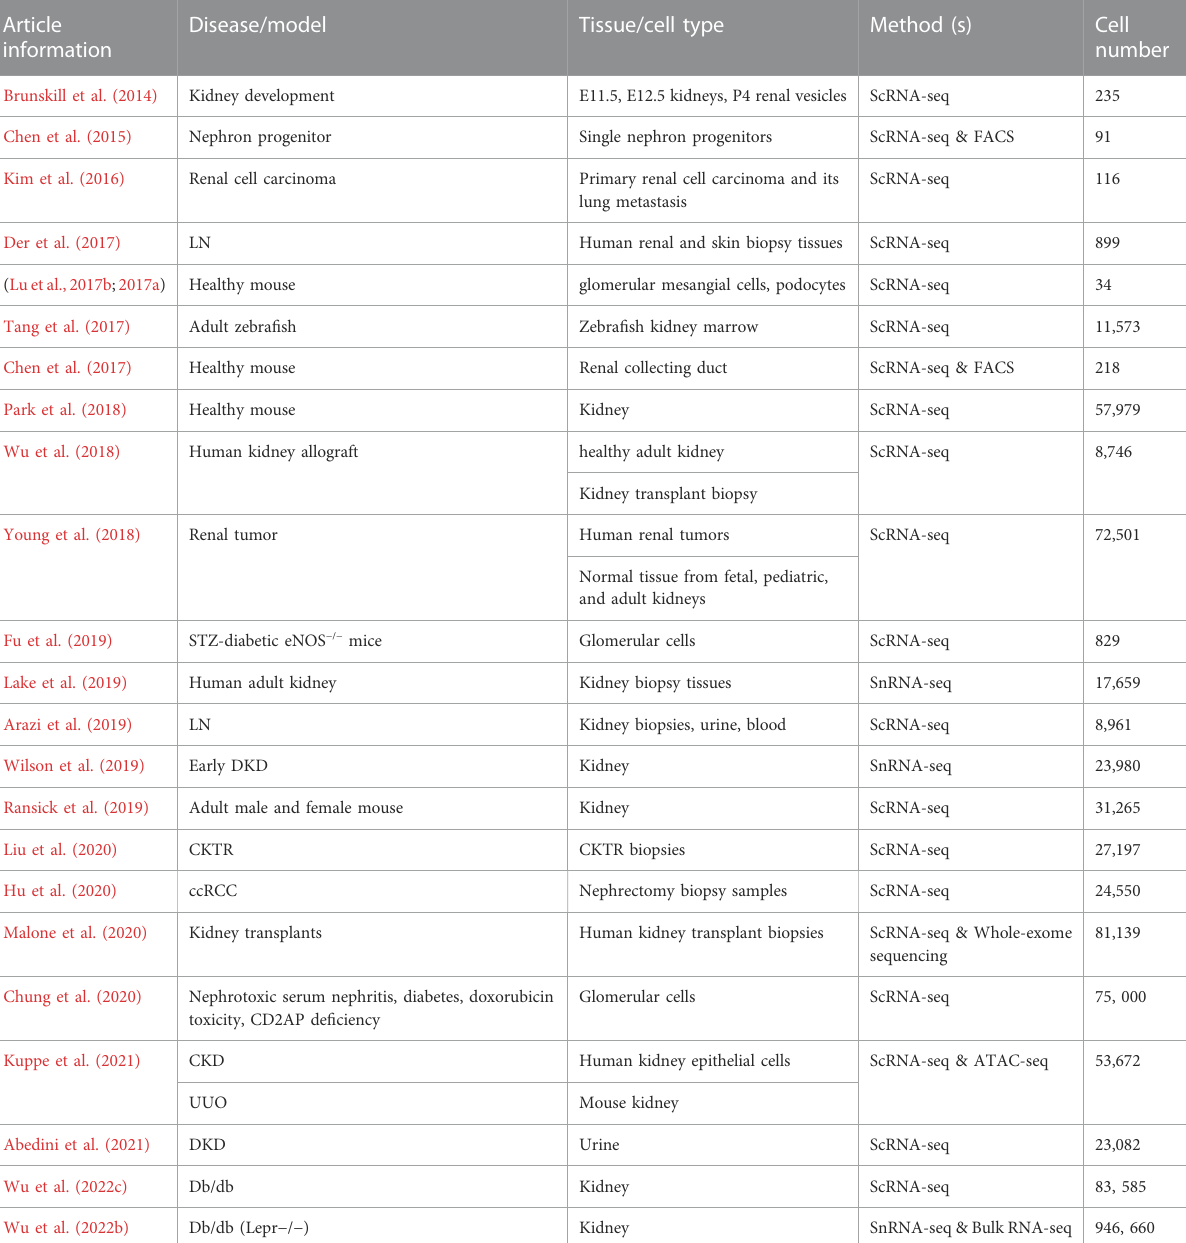
TABLE 2 Single-cell transcriptomics studies in